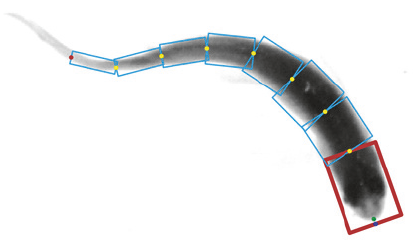
Figure 7: A fish represented by a chain of rectangles